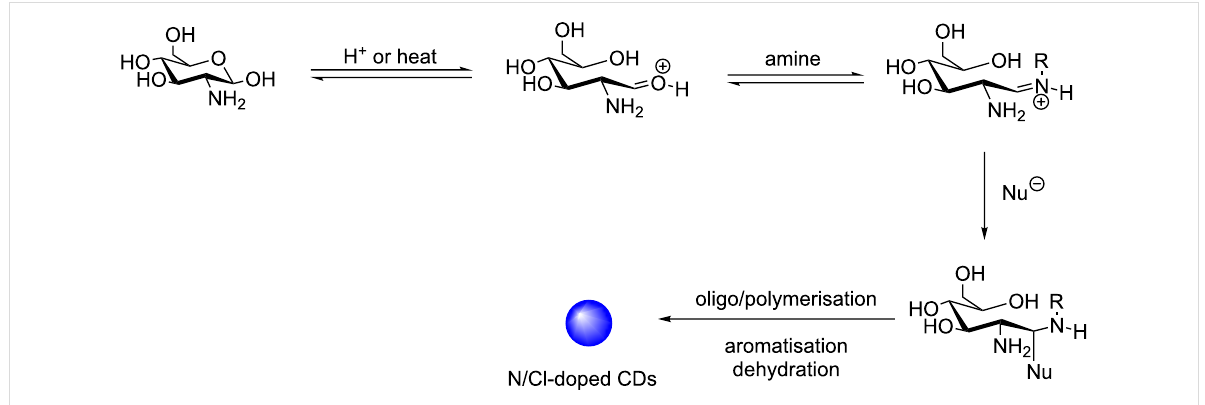
Scheme 17: Mechanism for the formation of N/Cl-doped CDs via key aldehyde and iminium intermediates, monitored by 1 H and 13 C NMR, FTIR and React-IR studies.